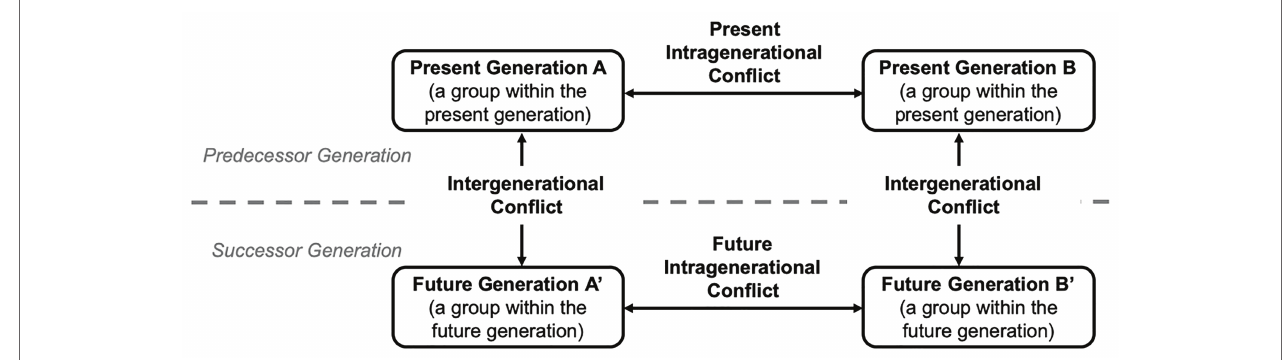
FIGURE 4 | The framework of interdependent conflicts in the intergenerational context. Figure 4 displays the interplay between the arising present intragenerational conflict (i.e., the conflict between different groups within the present generation), the intergenerational conflict (i.e., the conflict between the predecessor and successor generation of a group), and the future intragenerational conflict (i.e., the conflict between different groups within the future